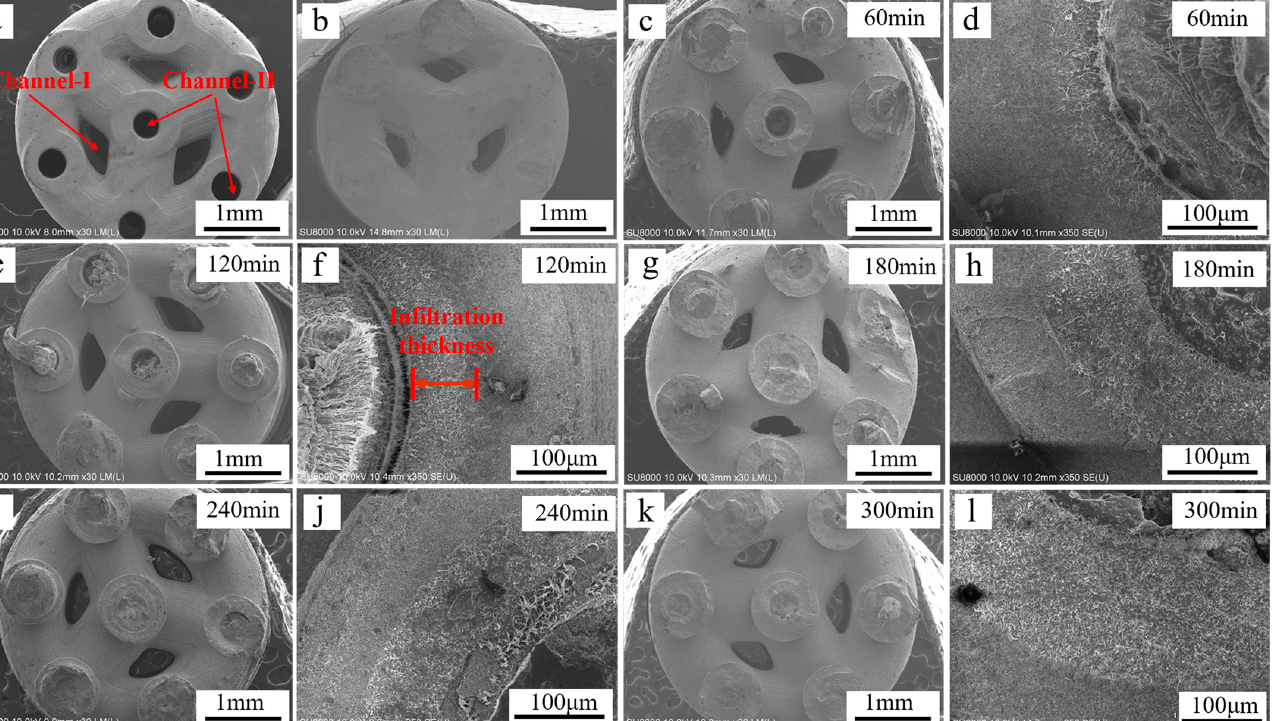
Figure 2. Photographs of β -TCP ceramic scaffolds (hollow scaffolds) fabricated for impregnation by DLP process (left: green scaffolds, right: sintered scaffolds).